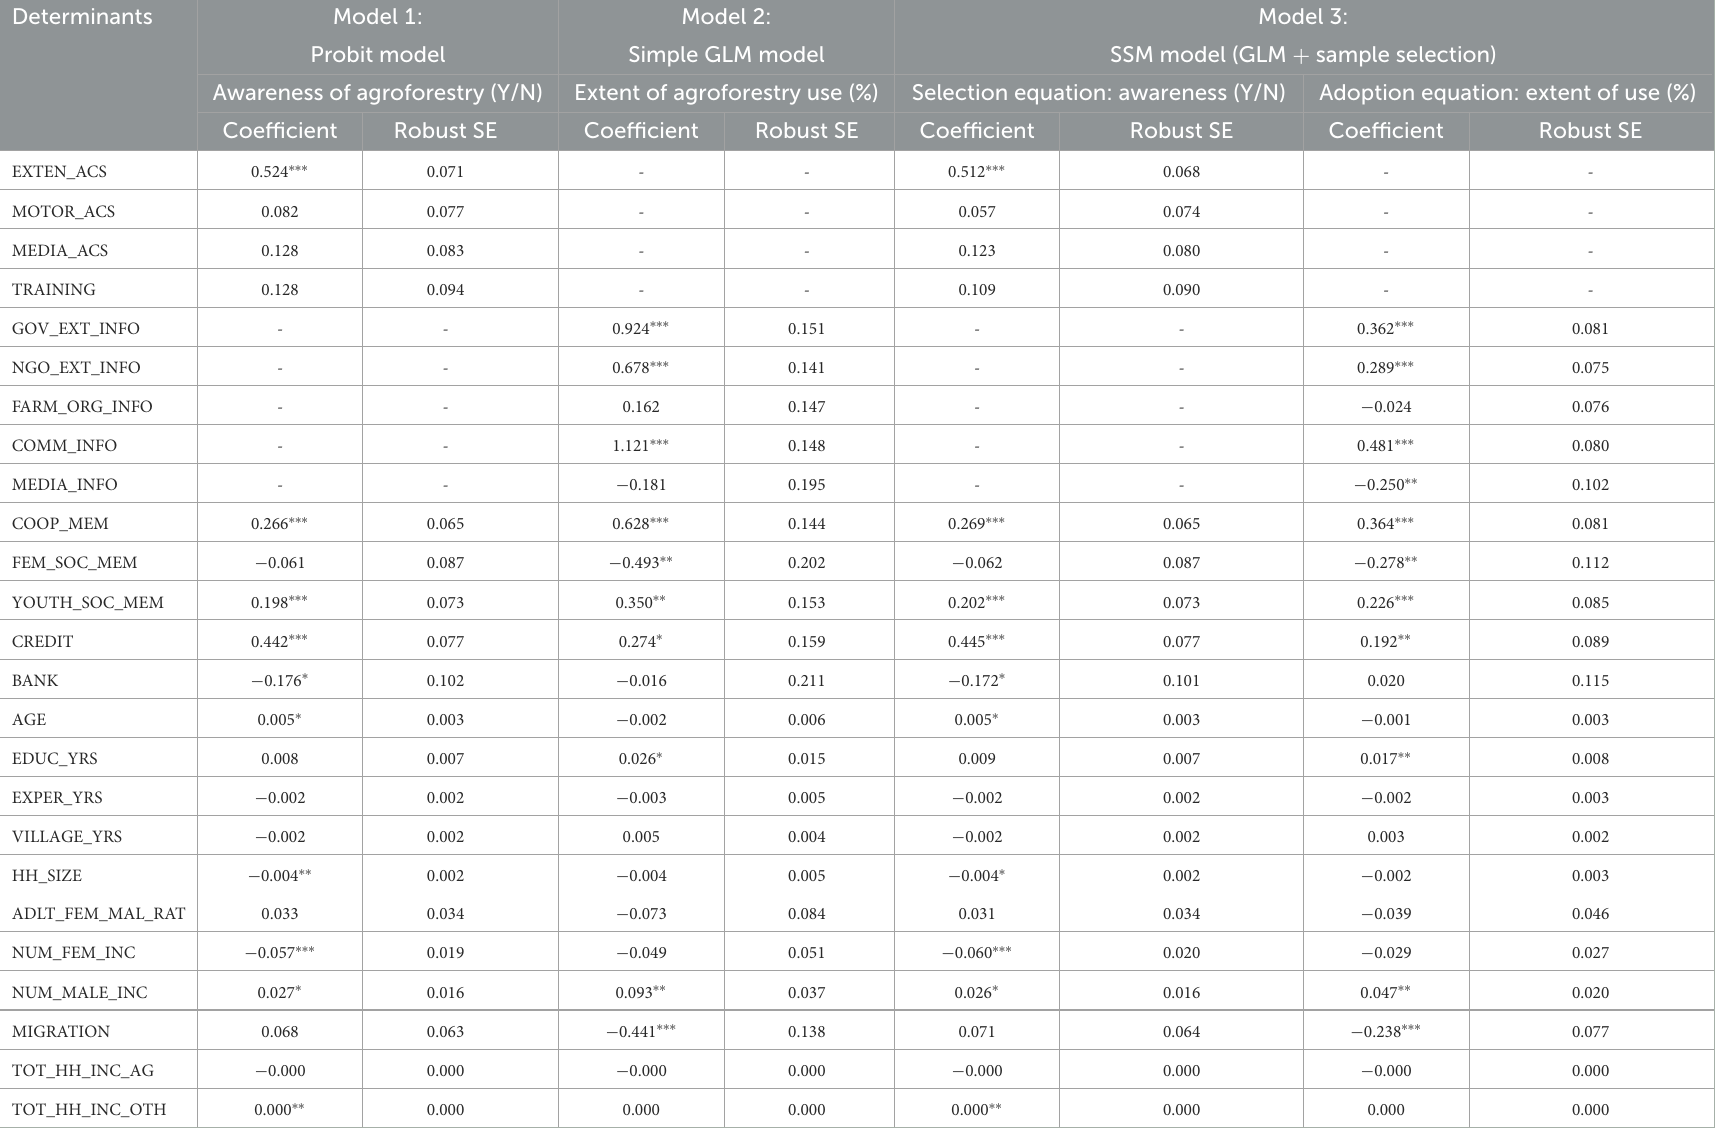
TABLE 5 Maximum likelihood estimates of models explaining agroforestry awareness and adoption across the four Mali sites, with and without sample